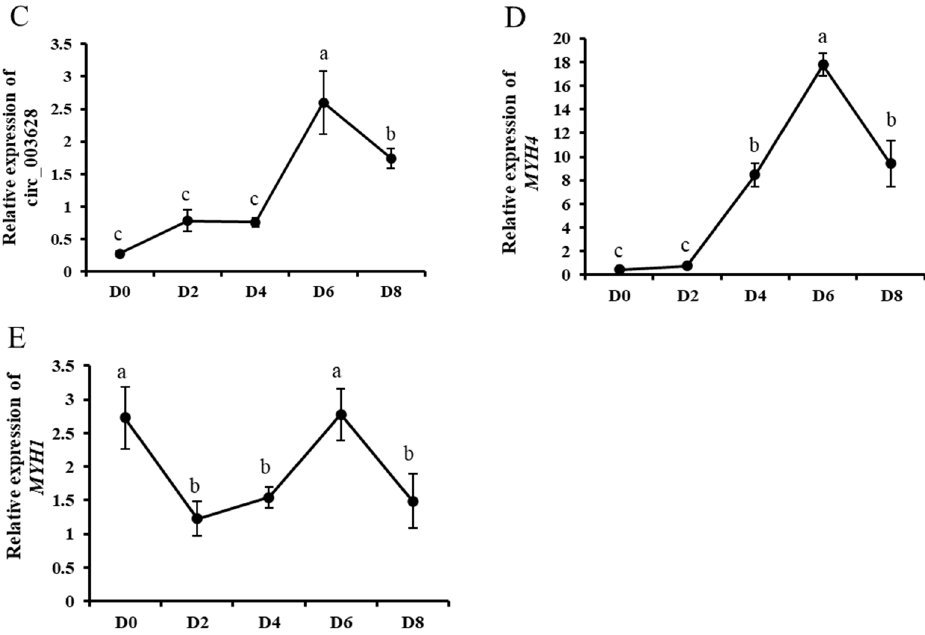
Figure 4. The expression levels of MyoD ( A ), MEF2C ( B ), circ_003628 ( C ), MYH4 ( D ) and MYH1 ( E ) on day 0, 2, 4, 6 and 8 after SMSCs differentiation. Different lowercase letters above the bars represent significant differences ( p < 0.05).